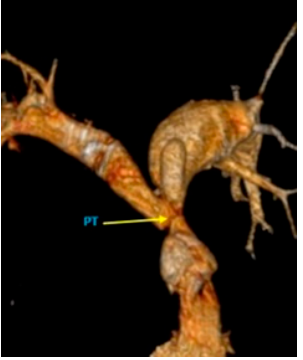
Figure 5. Pulmonary CTA, 3D